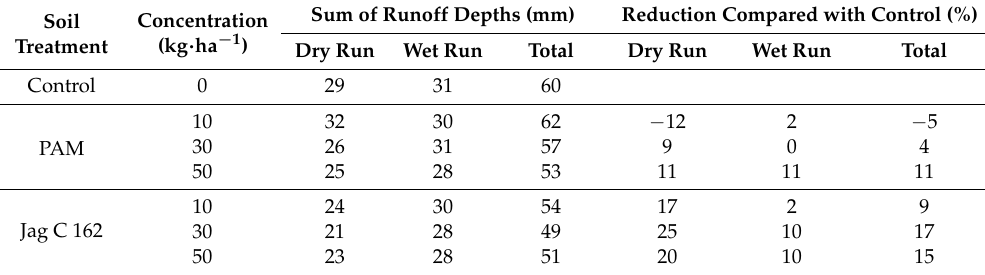
Table 1. Sum of runoff depths on soil surface treated with different concentrations of PAM and Jag C